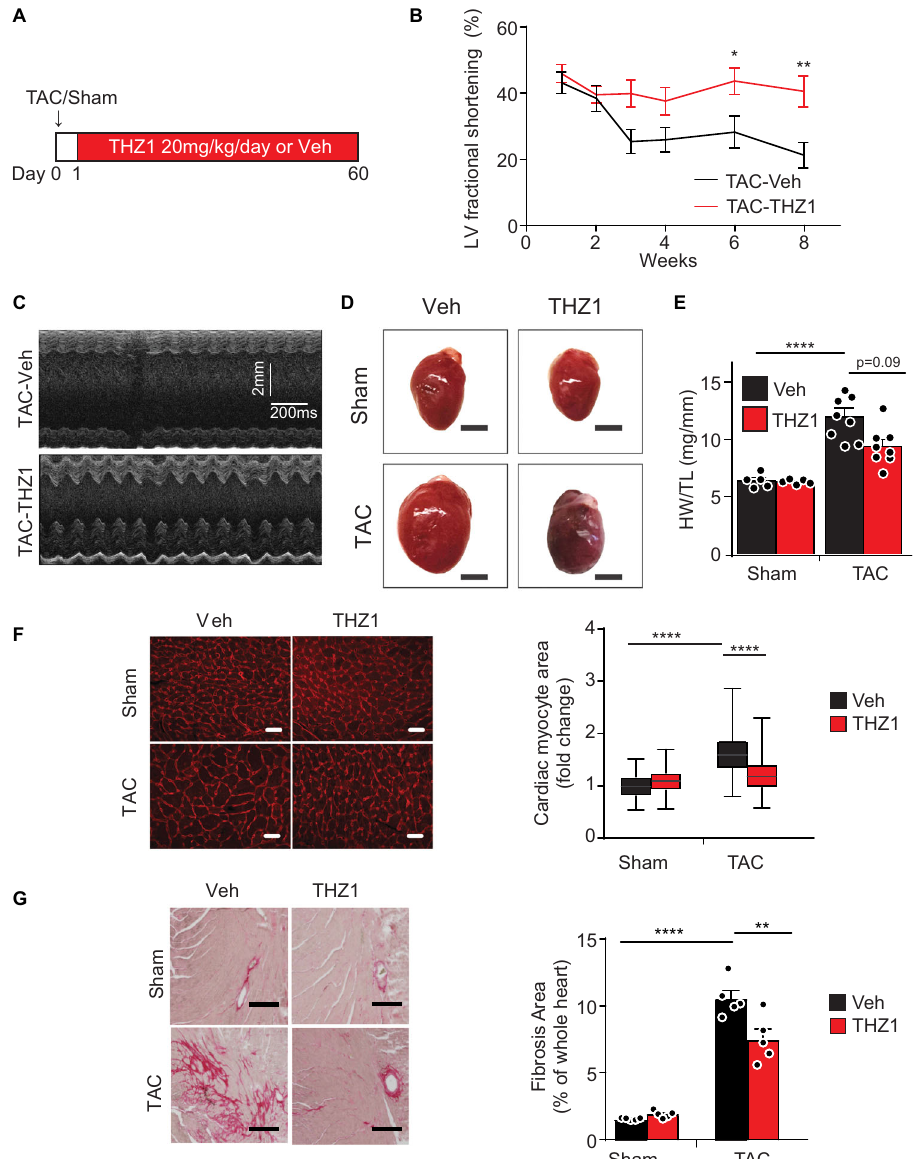
Fig. 3 THZ1 ameliorates cardinal features of adverse cardiac remodeling and HFrEF pathogenesis in mice. A Schema of the experimental design. B Two-dimensional echocardiographic quanti fi cation of left ventricle area fractional shortening in indicated groups ( n = 8). Echocardiography for the sham groups (Sham-Veh and Sham-THZ1) were performed at the end of the study (week 8) and are plotted alongside the week 8 TAC data in Supplementary Fig. 4A – C. * p = 0.0339, ** p = 0.0039. Two-way ANOVA with Holm – Sidak multiple comparisons correction was used for statistical analysis. C Representative M-mode echocardiographic images obtained at mid-papillary muscle level from parasternal short-axis view (8 weeks post- TAC). D , E Representative heart images and quanti fi cation of heart weight/tibial length (HW/TL) ratio at 8 weeks post-TAC. Scale bar: 3 mm. F Representative images of myocardium visualized by wheat germ agglutinin staining (red) and quanti fi cation of cardiomyocyte cross-sectional area in indicated groups at 8 weeks post-TAC (pooled analysis of 150 individual cardiomyocytes randomly selected from hearts of 3 independent animals per experimental condition). Scale bar: 20 μ m. Data presented as standard box-and-whisker plots showing median cardiomyocyte area (horizontal line). Upper and lower quartiles are designated by the box and whiskers designate upper and lower extremes. G Representative heart cross sections stained with picrosirius red with quanti fi cation of fi brosis area in indicated groups ( n = 5; 8 weeks post-TAC). ** p = 0.0027. Scale bar: 200 μ m. * p <